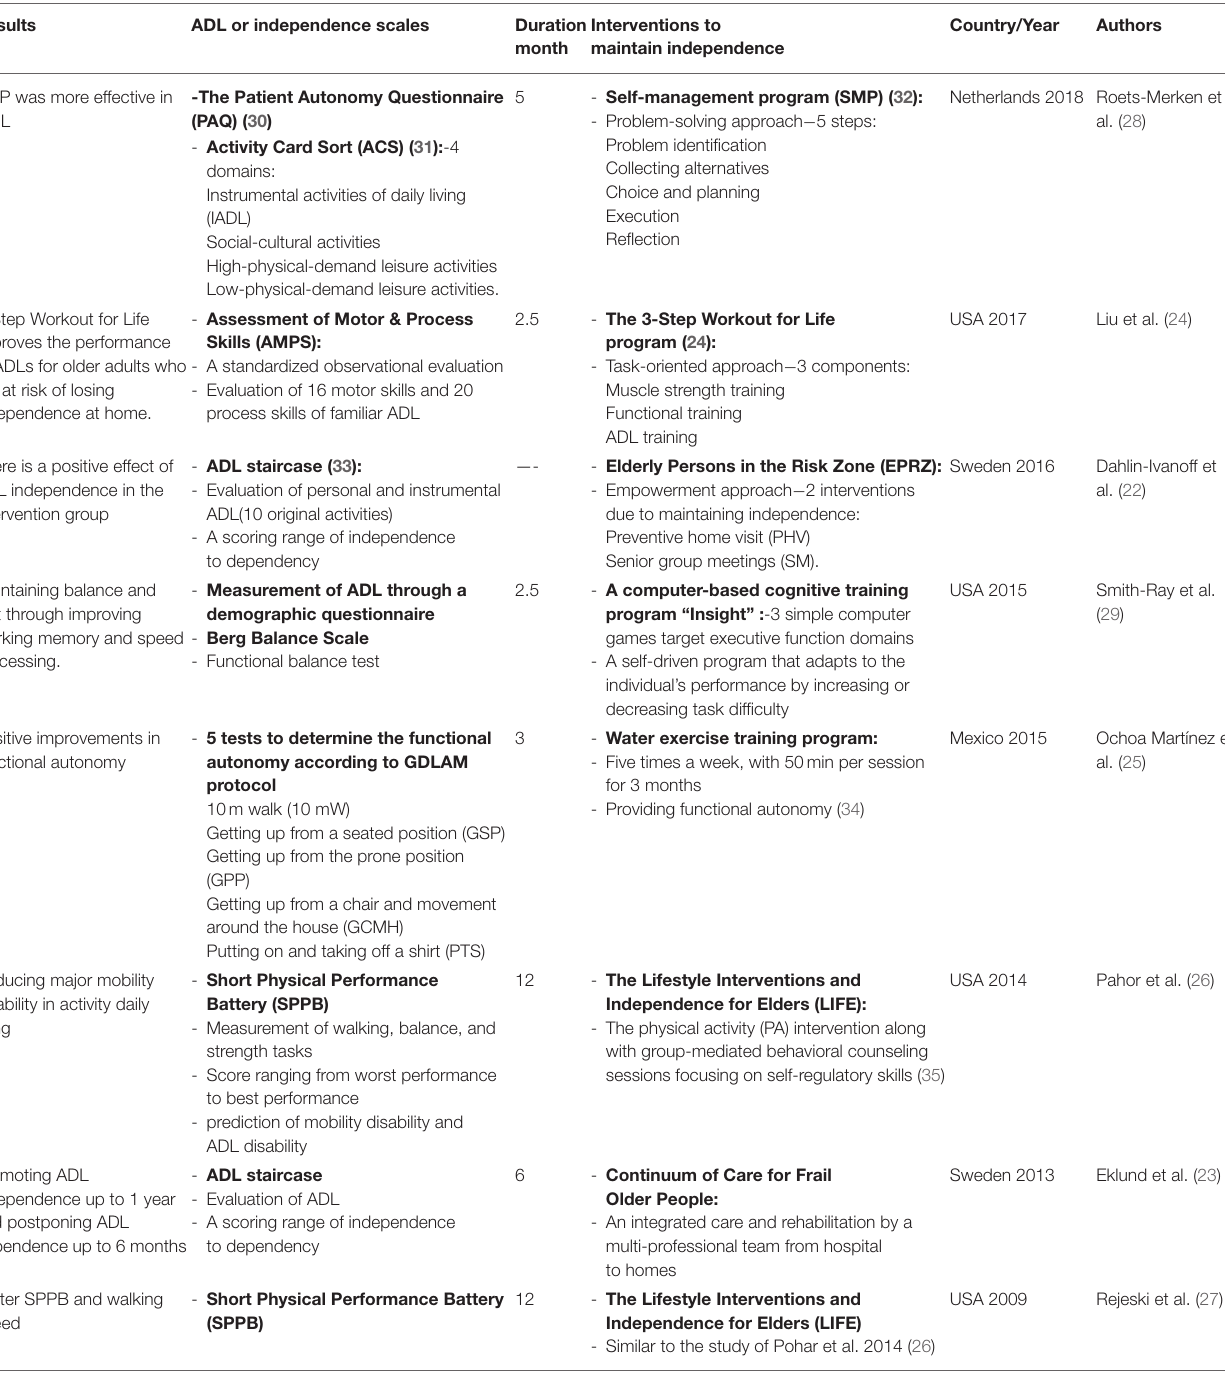
TABLE 1 | Summary of the included RCT